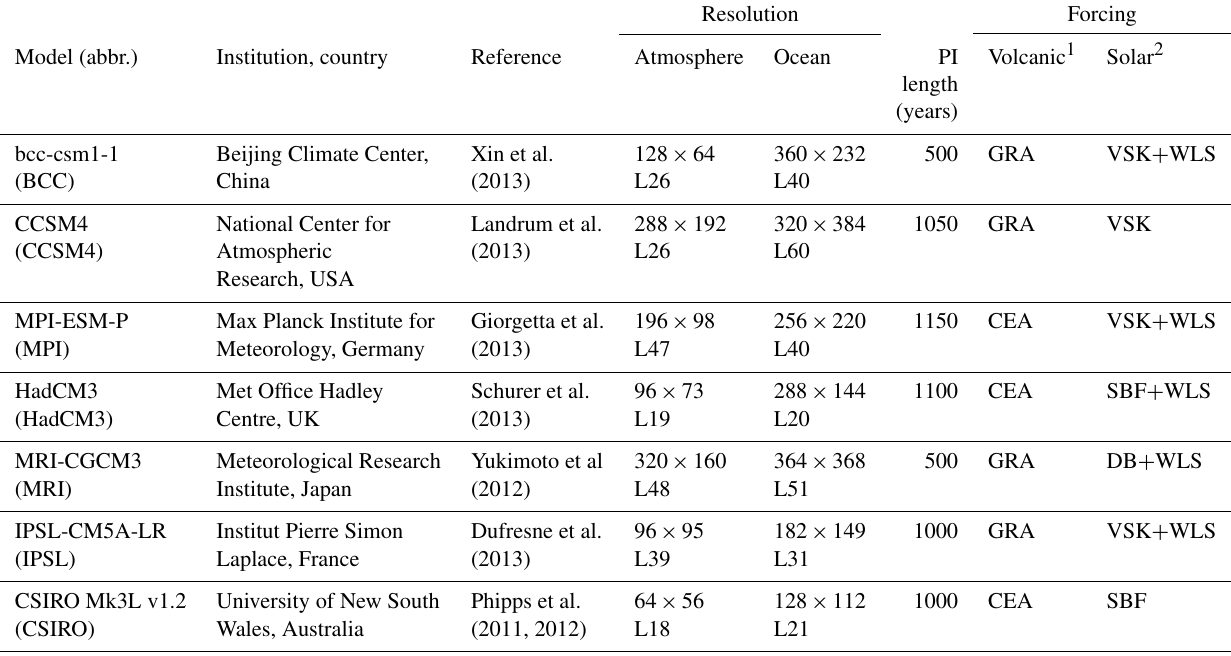
Table 1. Summary of the CMIP5-PMIP3 climate models considered in this study and the volcanic and solar forcing applied in their last millennium simulations. The simulation length of last millennium and historical simulations together for all the seven models is 1151 years (850–2000).